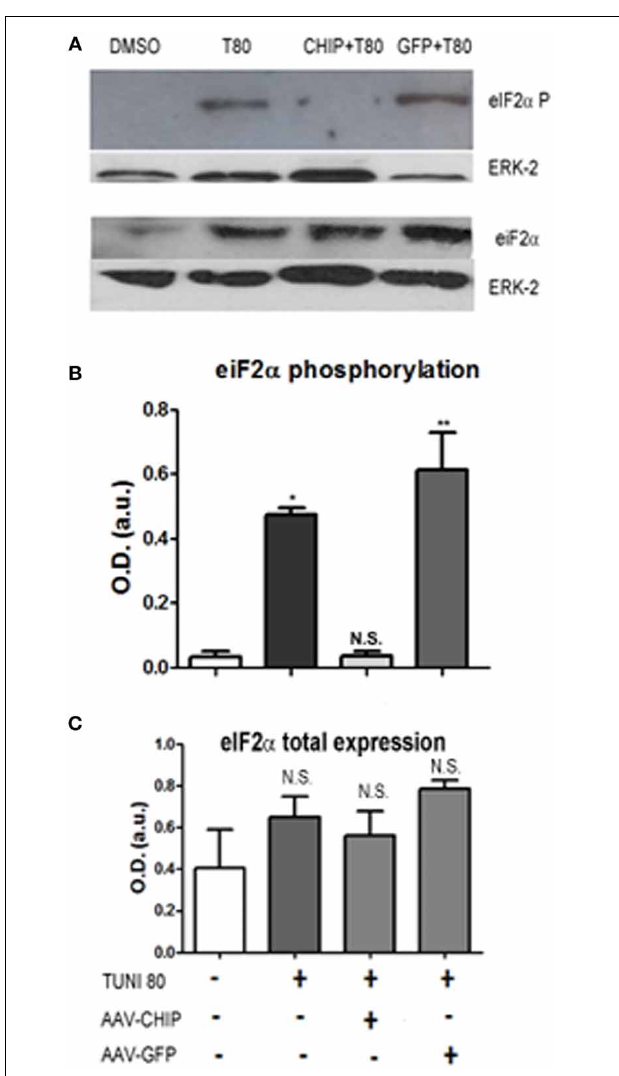
FIGURE 6 | Overexpression of CHIP reduces eIF2- α phosphorylation after Tunicamycin treatment. Western Blot (A) for phosphorylated eIF2- α (upper) and total eIF2- α expression (down) comparing vehicles (DMSO) to treated/infected slices. ERK-2 was used as a loading control. (B,C) Quantificationforopticaldensity(O.D) ∗ p < 0 . 1, ∗∗ p < 0 . 05.Valuesrepresent ± S.E.M. compared to vehicles. P < 0 . 1, C.I.: 90%, N = 3 independent